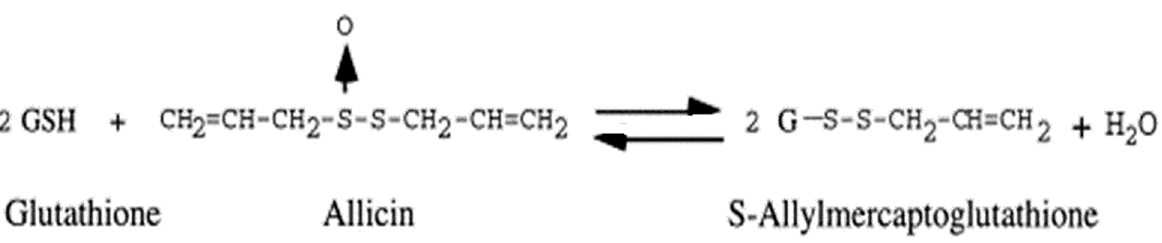
Figure 4. Reaction of GSH with allicin.